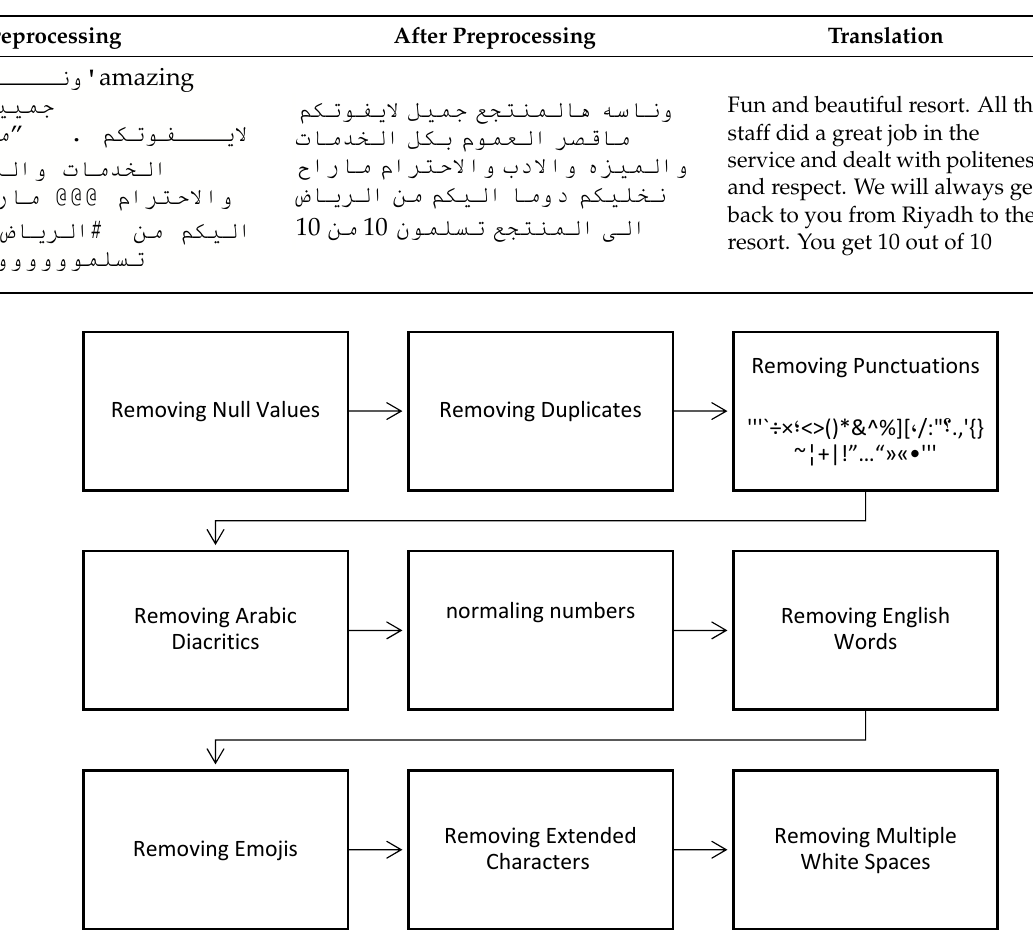
Table 2. Preprocessing applied to a sample review.